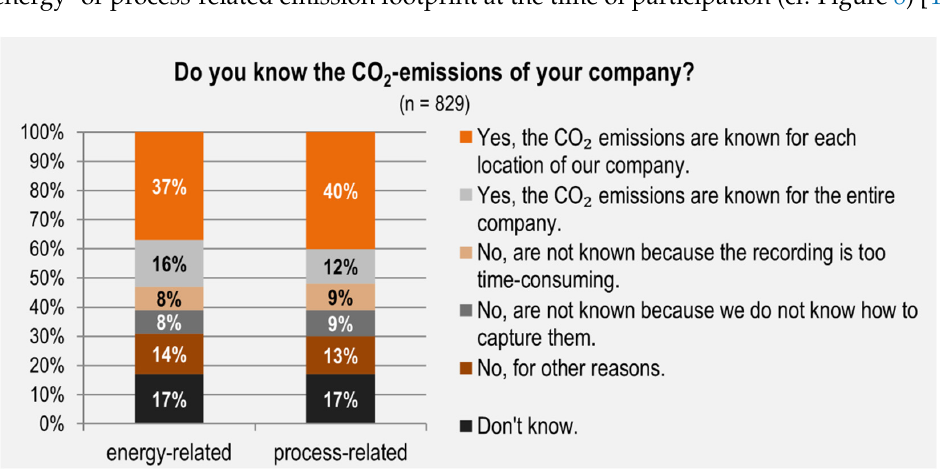
Figure 8. Companies’ knowledge of energy- and process-related CO 2 -emissions [41].